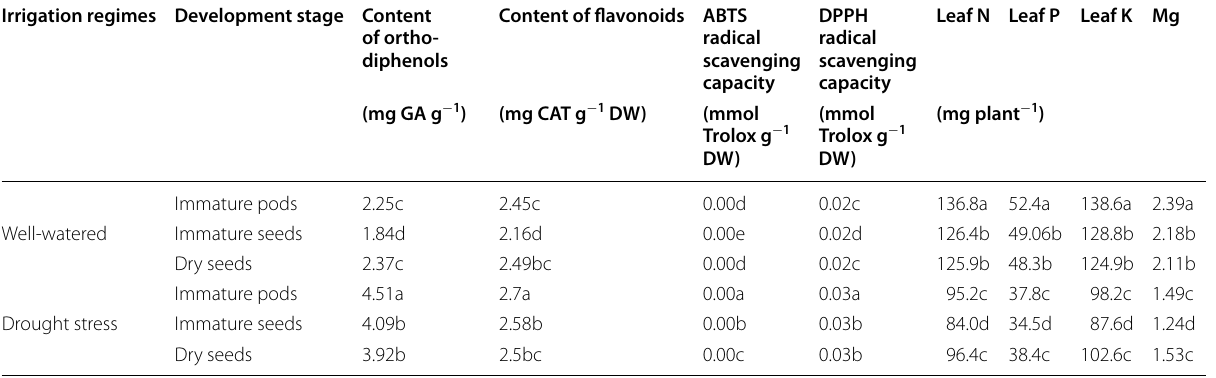
Each parameter with the same letter is not significantly different according to LSD test at the 5% level of probability